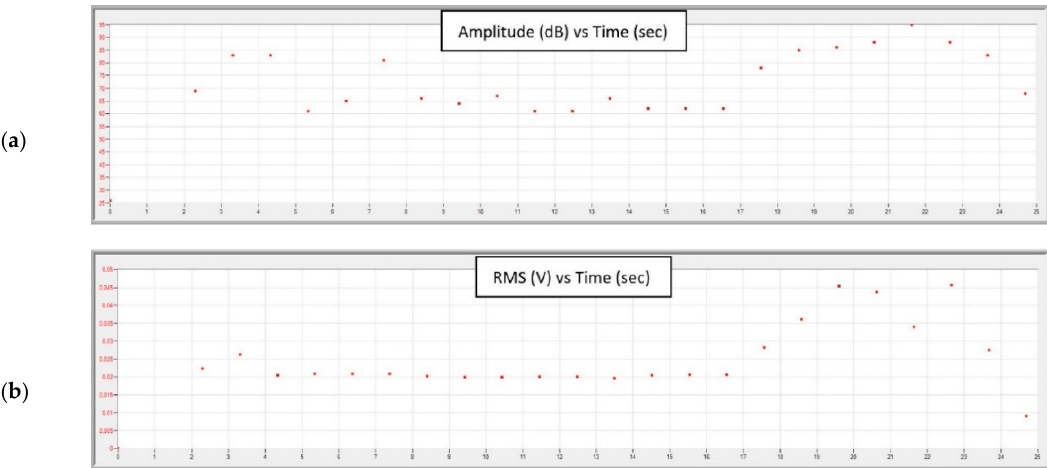
Figure 15. Charts of ( a ) amplitude and ( b ) RMS changing as a function of time during turning with parameters: ap = 2.0 mm, f = 0.05 mm/rev.